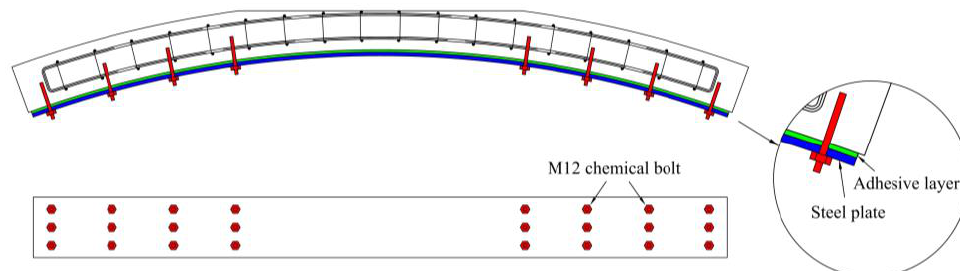
Figure 1. Model setup.